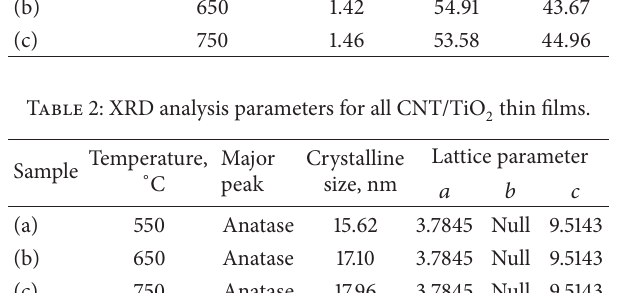
Table 1: EDX analysis data for all CNT/TiO